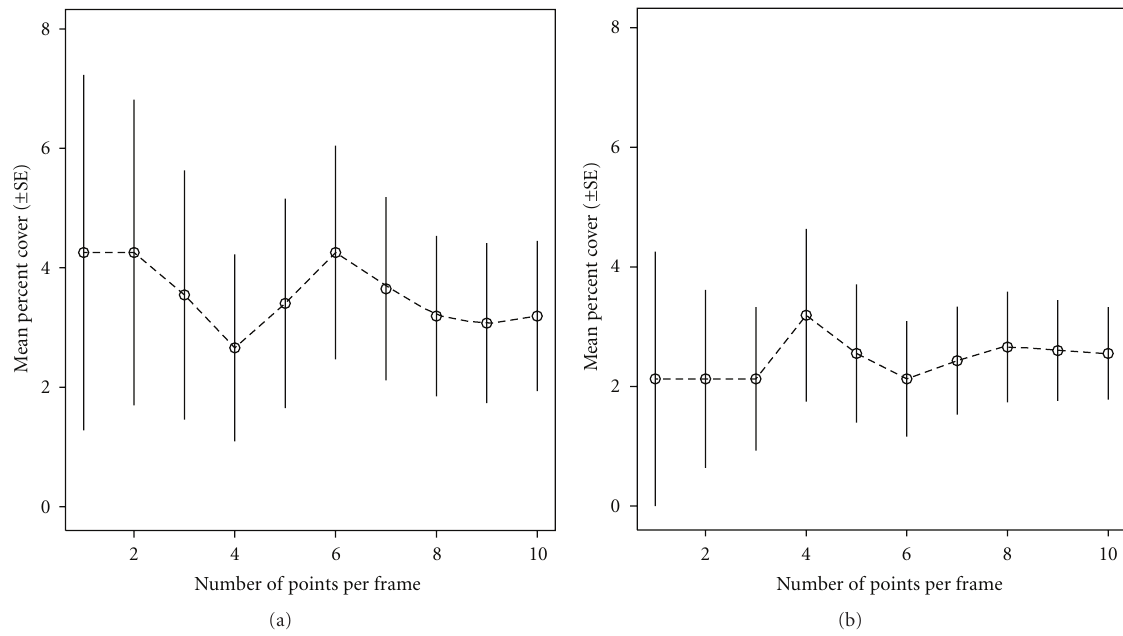
Figure 1: Comparison between ground-truth (a) and simulated (b) estimates of mean percent cover ( ± SE) using di ff erent numbers of points per frame. Ground-truth data are sponge cover estimates from a 20-m long transect video recorded at Rainbow Gardens Reef in 2004. Simulated sponge cover estimates are based on field estimates of μ (3%) and σ (0.8).